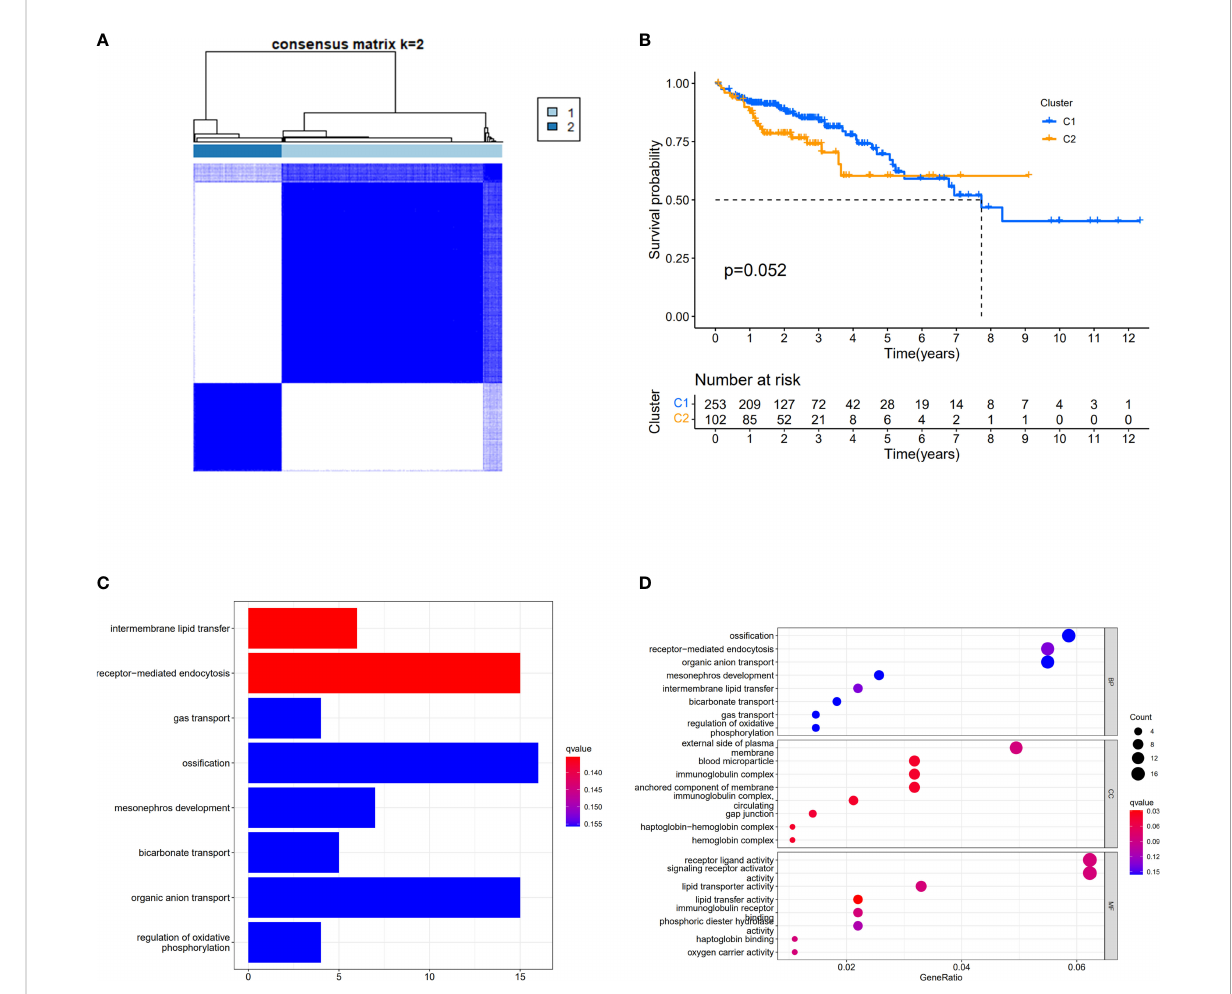
FIGURE 3 Divided COAD patients into two different clusters. (A) Consensus clustering matrix for k = 2. (B) Kaplan – Meier curves of OS for two clusters in COAD. (C) KEGG analysis of the curoptosis-related genes. (D) GO analysis of the curoptosis-related